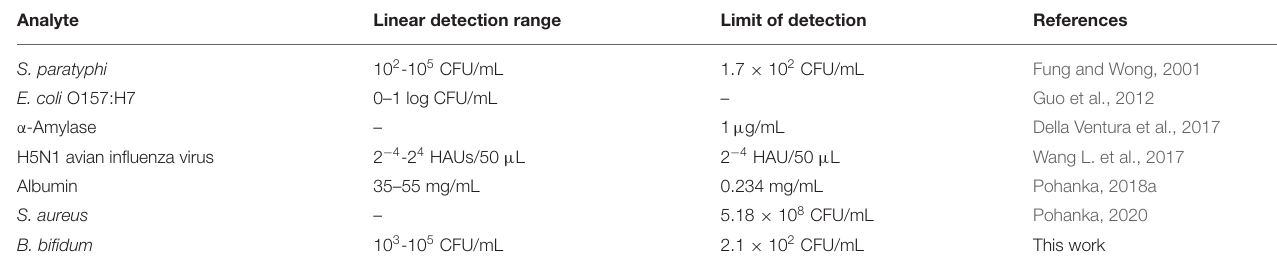
TABLE 1 | Sensing performance of the proposed QCM sensor with other